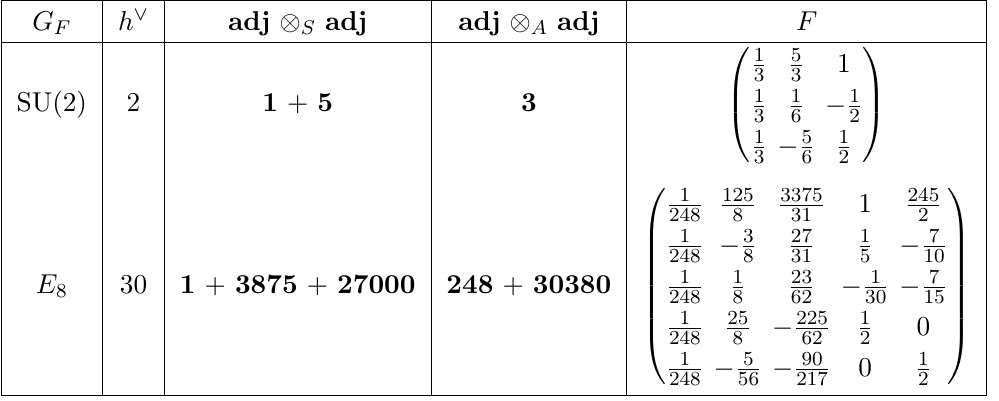
Table 1 . The decomposition of adj (cid:10) adj into irreducible representations and the crossing matrices for SU(2) and E 8 (cid:13)avor groups. The basis of representations in the crossing matrix are in the order shown in columns adj (cid:10) S adj and then adj (cid:10) A adj